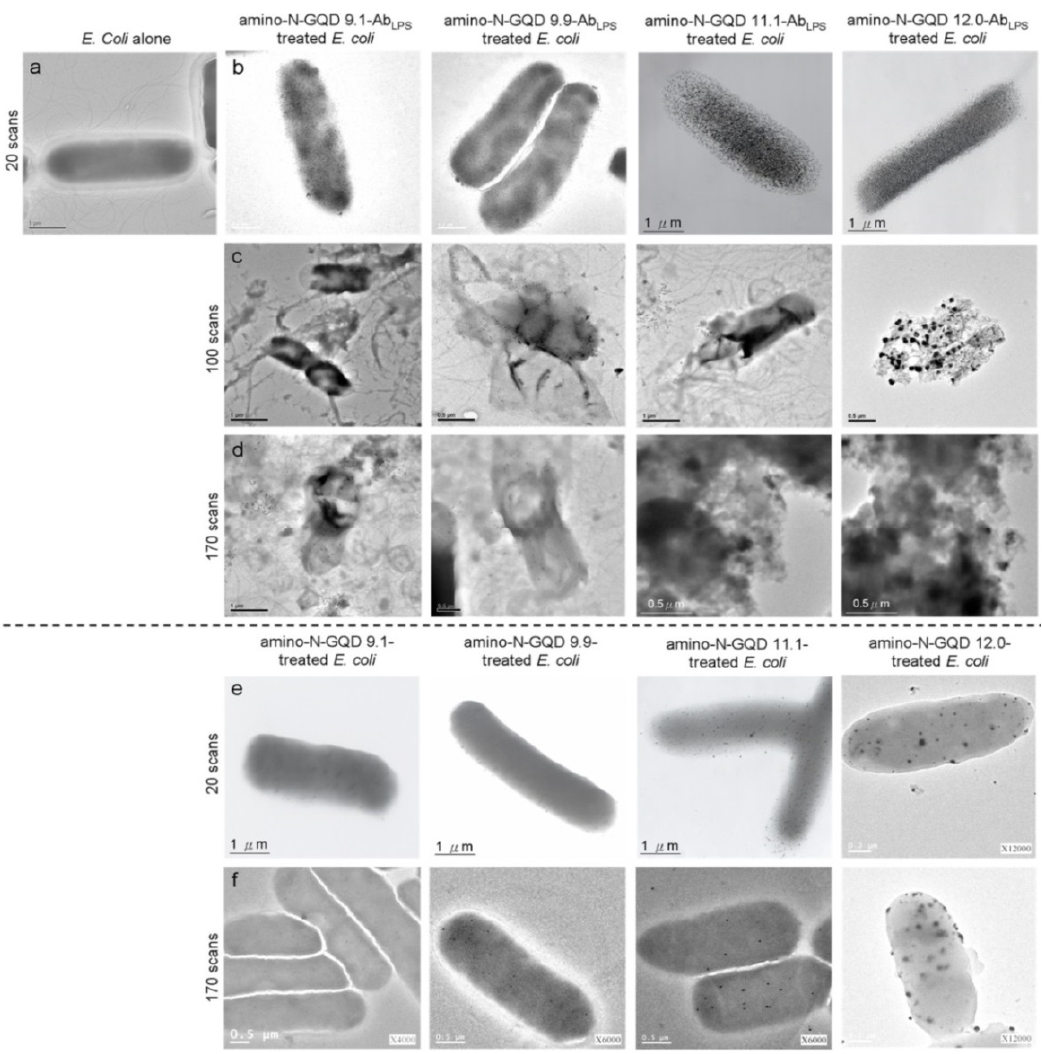
Figure 4. TEM images of the ( a ) bare E. coli (with 20 scans), ( b – d ) sorted amino-N-GQD–Ab LPS - treated E. coli (with 20, 100, and 170 scans), and ( e , f ) sorted amino-N-GQD-treated E. coli (with 20 and 170 scans) under TPE (222.7 nJ pixel − 1 ). All images were acquired after 3 h of additional incubation. TPE wavelength: 960 nm. Delivered dose (OD 600 ): approximately 0.05 of E. coli or 0.75 µ g mL − 1 material–Ab LPS .